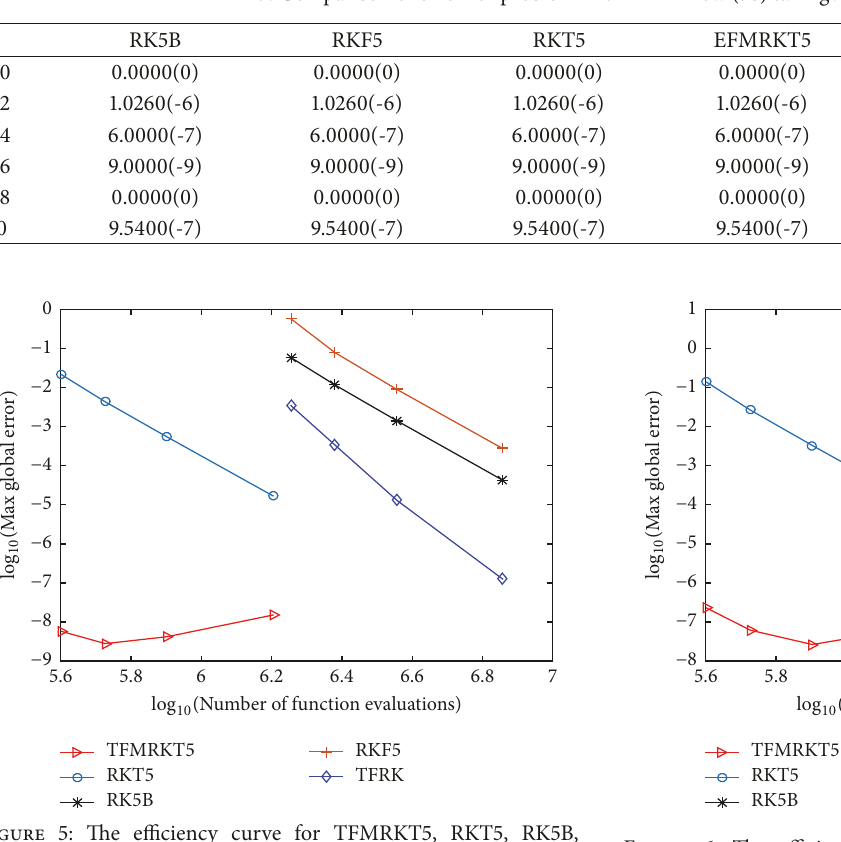
Figure 6: The efficiency curve for TFMRKT5, RKT5, RK5B, RKF5, and TFRK for Problem 7 with 𝑥 𝑒𝑛𝑑 = 10000 and ℎ = 0.025, 0.05, 0.075, 0.1